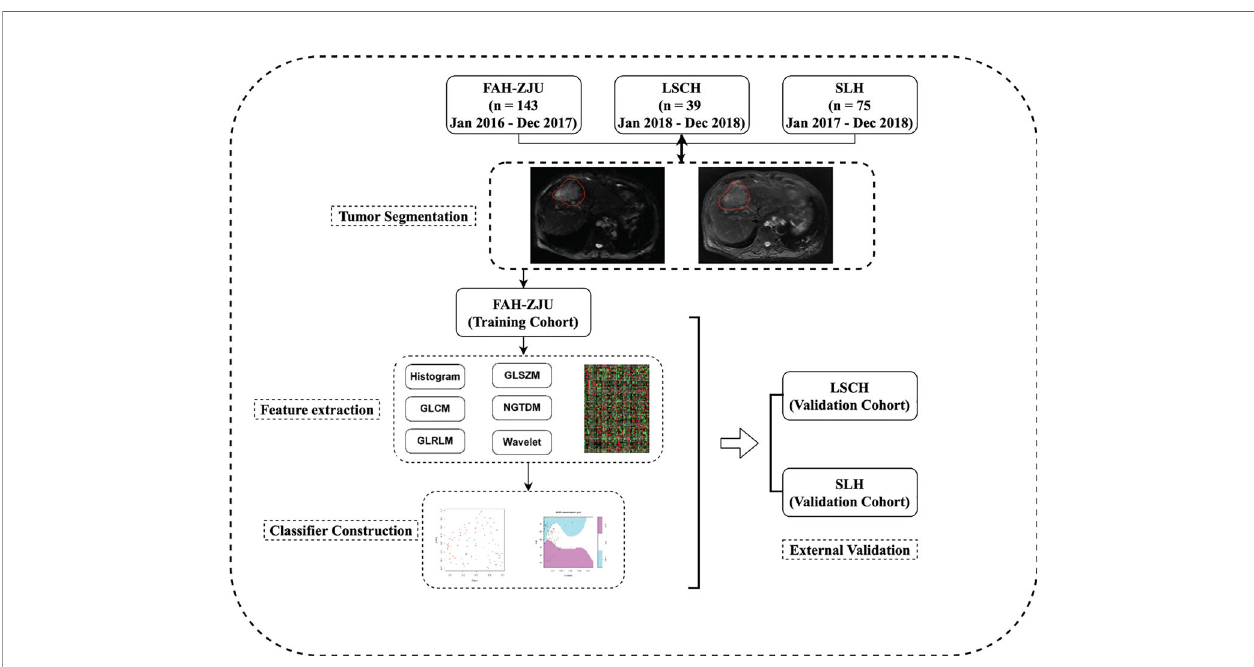
FIGURE 1 | Overview of the proposed study design. In general, this study contains four parts: (1) retrospective collection of presurgery gadoxetic acid-enhanced MRI; (2) tumor segmentation; (3) feature extraction and subsequent ranking; (4) predictive classi fi er construction and independent